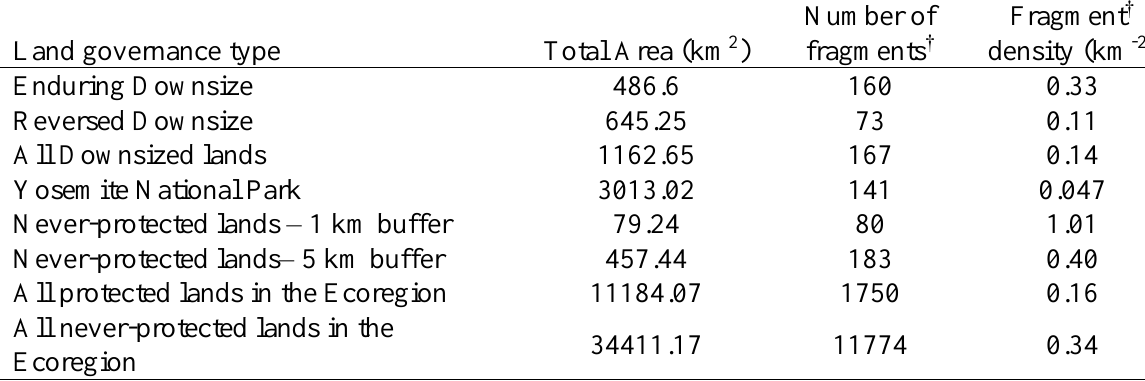
† Fragment: parcel of land surrounded by roads on all